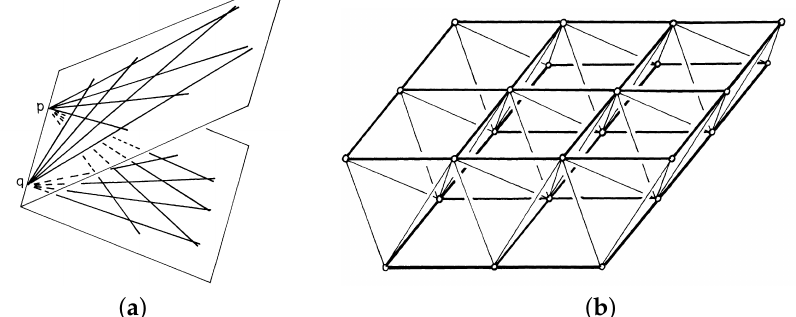
Figure 24. If we add a lot of extra edges to a bipartite framework on two planes, and they lie in these two planes and through two points on the intersection of the planes ( a ), then there is a non-trivial infinitesimal motion. The half-octahedral-tetrahedral truss ( b ) has this form, with the bipartite graph simplified, but still having an infinitesimal